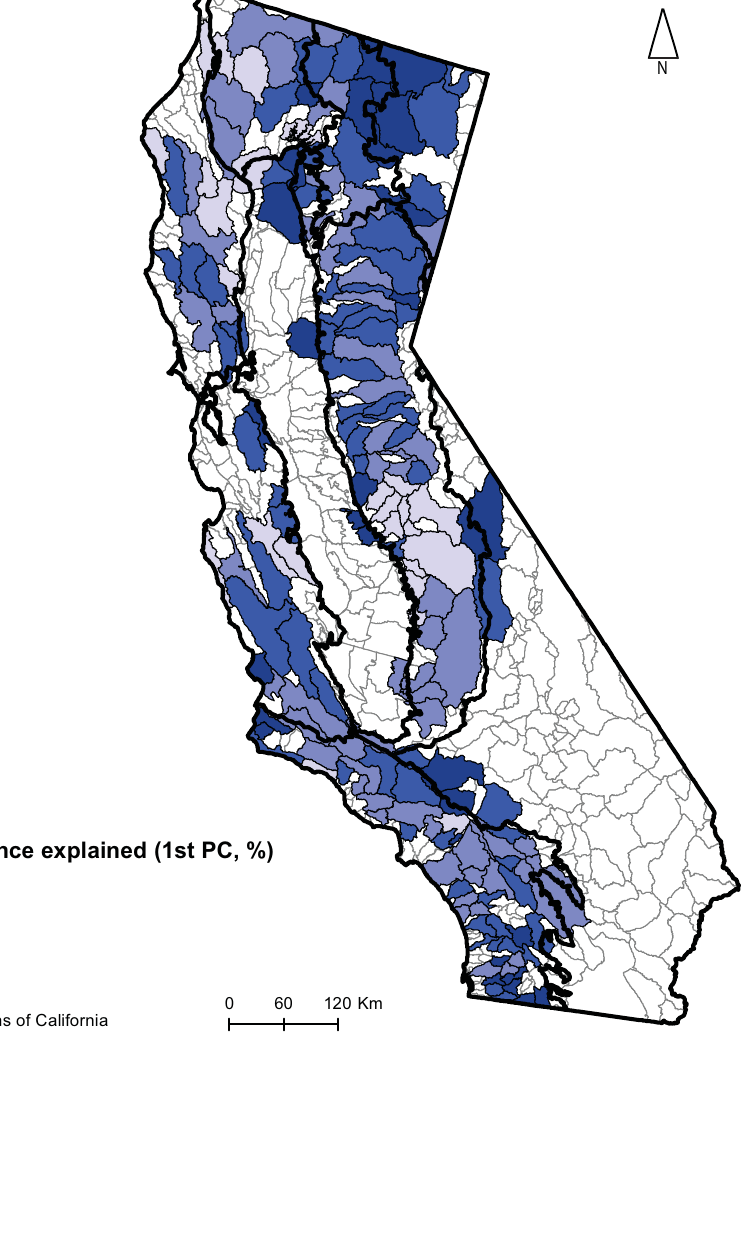
Figure 4. Mean fire elongation in each watershed. This metric is computed as the mean variance explained by the first principal component of all fires in the